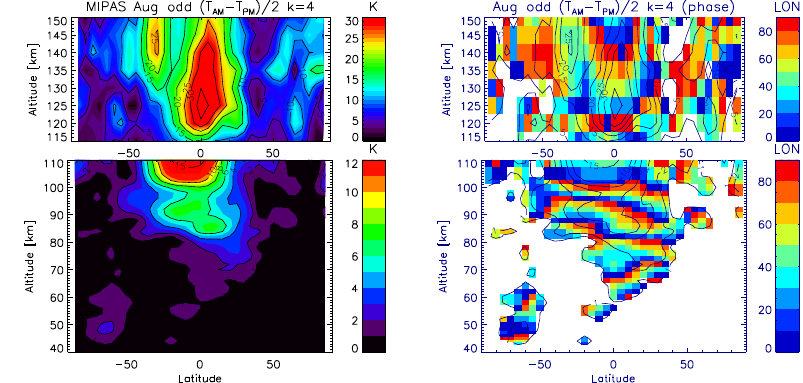
Figure 11. August average (2007–2012) monthly mean amplitudes (left) and phases (right) | n odd − s | = 4 oscillations from MIPAS T THER (115–150km; upper panels) and T MLT (20–110km; bottom panels) temperatures. Note the different color scale. DE3, DW5 and TE1 tides are